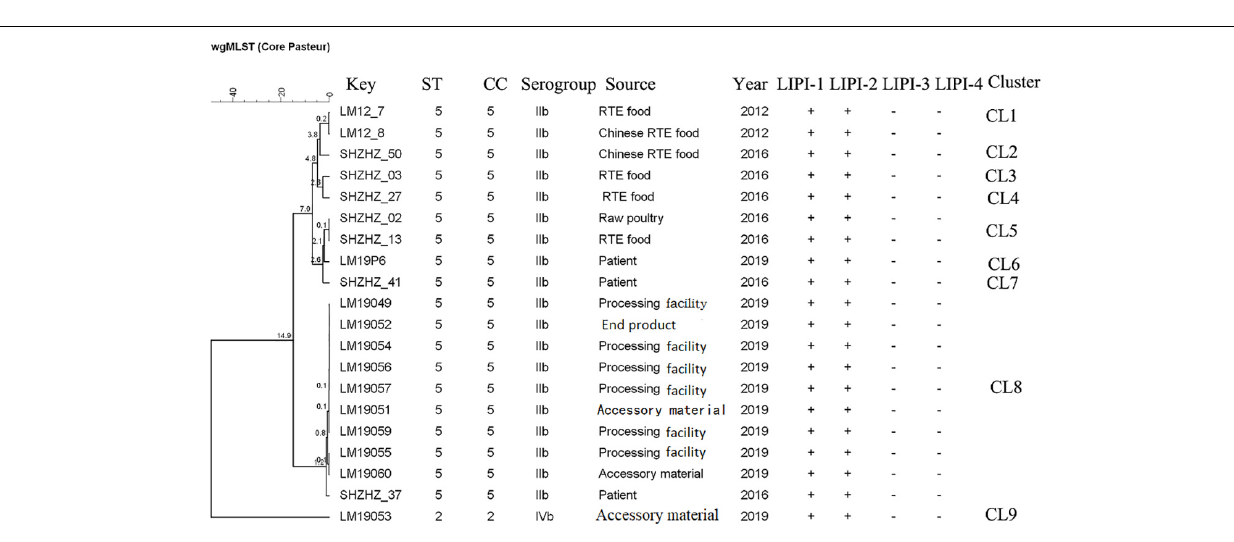
FIGURE 2 | Minimum spanning tree of cgMLST data for 20 L. monocytogenes isolates. The multiplication by 10 in the tree represents the number of different alleles among isolates. The corresponding data, including the name of the isolate (key), MLST type (ST), MLST clonal complex (CC), source, year, Listeria pathogenicity island (LIPI-1, LIPI-2, LIPI-3, and LIPI-4), and cluster are shown alongside the dendrogram to the